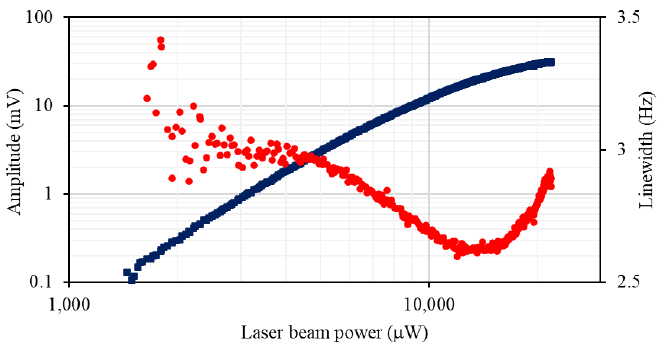
Figure 10. The amplitude (blue squares) and linewidth (red dots) of the rf spectrum profile versus the laser beam power in a single beam configuration.